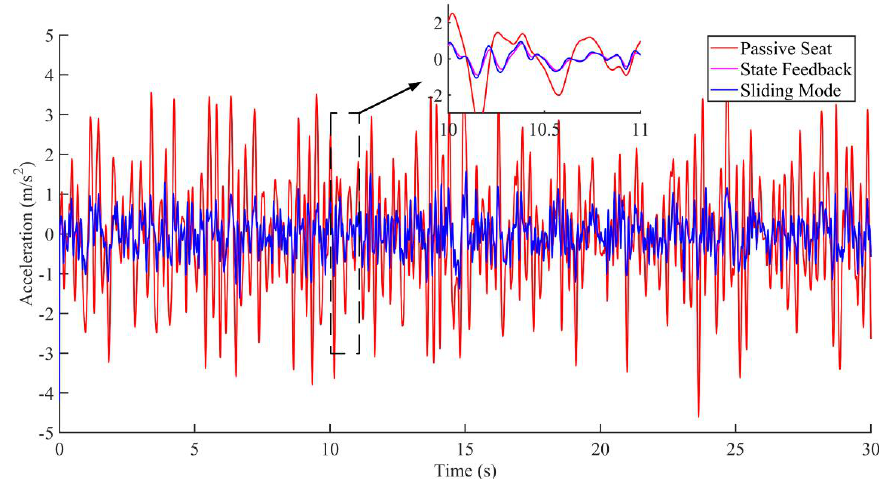
Figure 13. Comparison between actual value and expected value of vibration displacement based on integral sliding mode control under the condition of no interference.